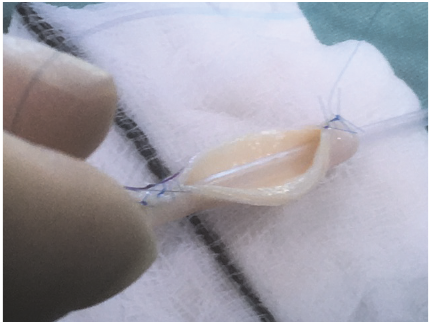
Figure 1: Aortic patch over Nelaton 8 ch catheter.